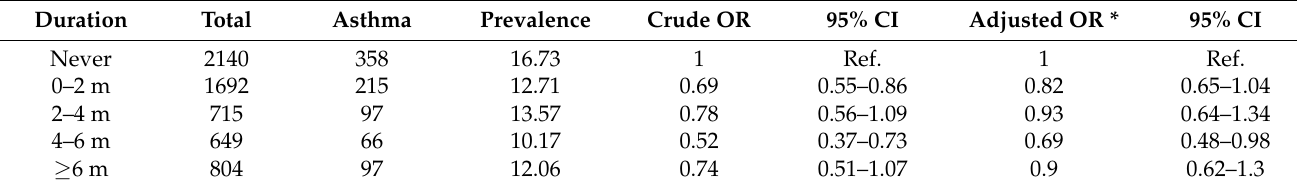
Figure 1. Flow chart of study population. Table 2. Association of breastmilk feeding duration with risk of